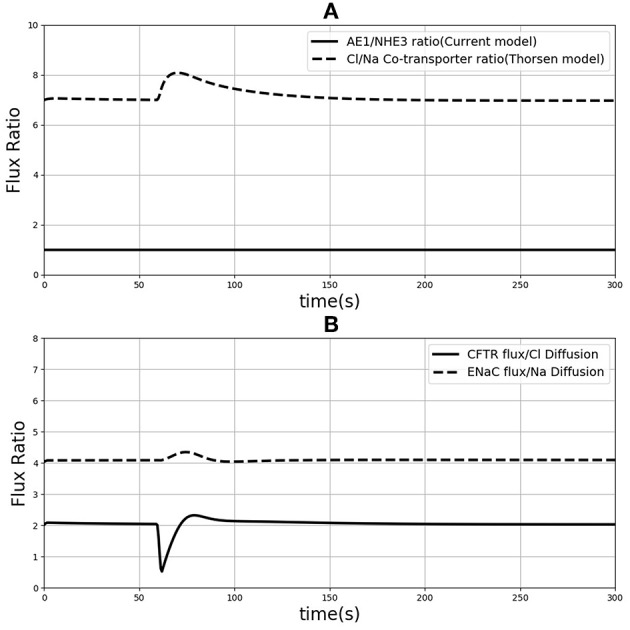
(A) Ratio of sodium flux and Chloride flux through NHE3 and AE1 compare to NaCl co-transporter flux in the Thorsen model. (B) Chloride flux through CFTR and chloride diffusion ratio compare to the ration of sodium flux through ENaC and sodium diffusion.